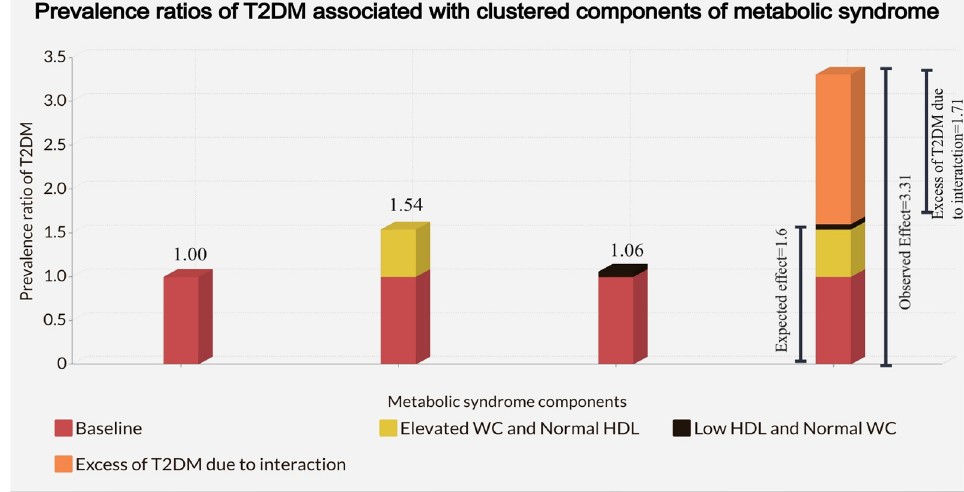
Figure 1. Adjusted Prevalence ratios of T2DM associated with the independent effect of elevated WC and low HDL and clustering of elevated WC and Low HDL in the stratum formed by high TG or high BP in 37,815 adolescents in the Study of Cardiovascular Risk Factors (ERICA, 2013 – 2014). Adjustment was made for age, sex, obesity, physical inactivity, sedentary behavior, alcohol consumption, smoking status, and socioeconomic status.